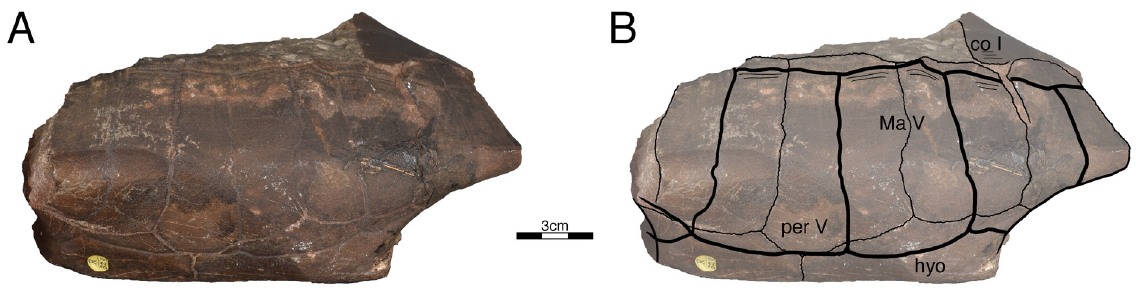
view. Scale bar: 3 cm.